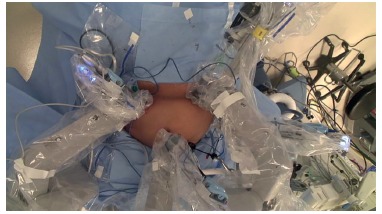
Positioning of trocars after docking the robot